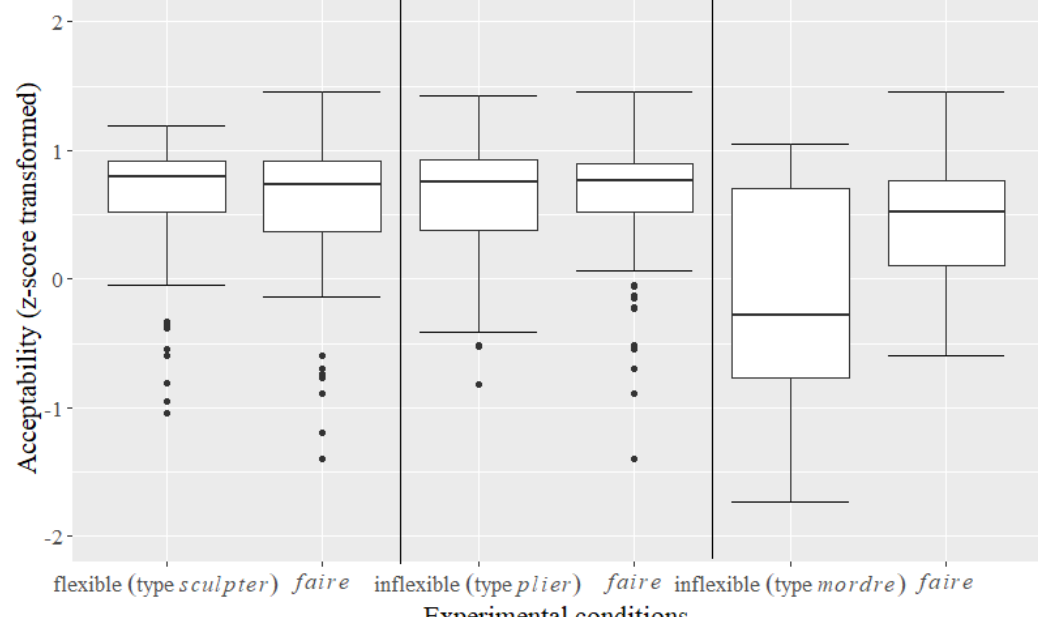
Figure 1 . Acceptability of verbs with effected objects (N = 600, N for each condition [from left to right] = 150, 150, 75, 75, 75,